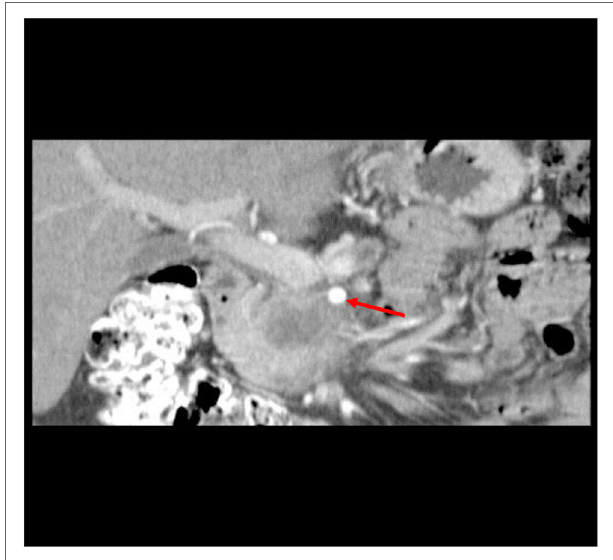
FIgURe 1 | CT abdomen at initial work-up that shows a hypo-attenuated mass in the region of the uncinate process contacting 50% of the superior mesenteric vein, and approximately 25% of the superior mesenteric artery (see arrow) as well as contacting the left renal vein.